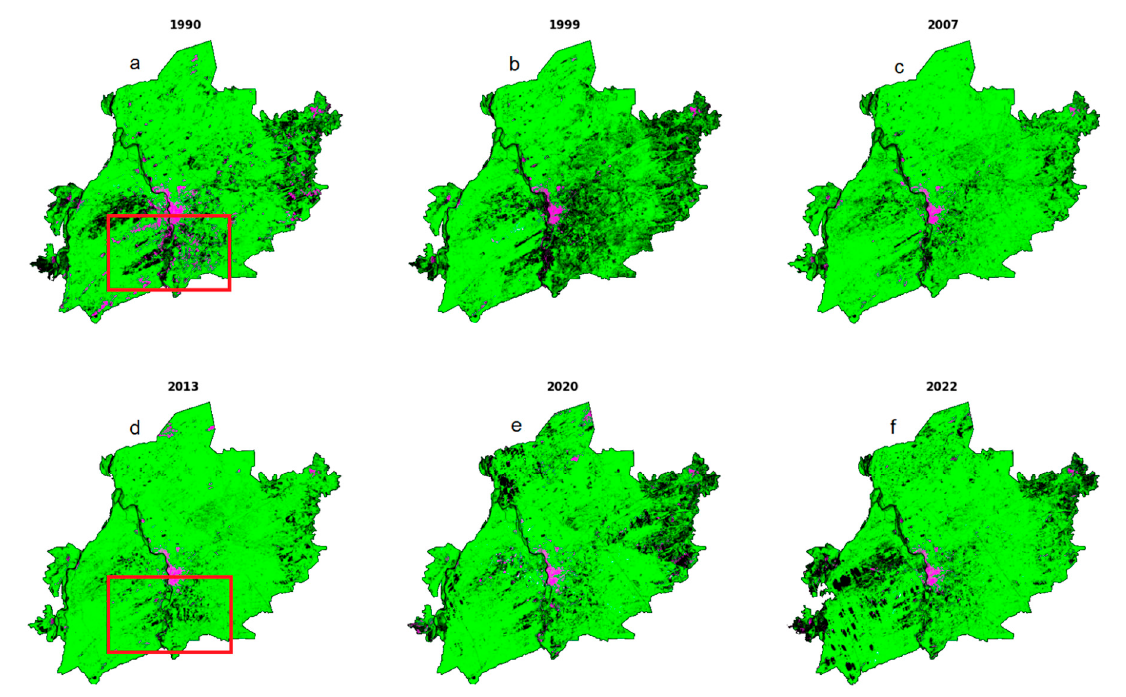
Figure 5. Mapping of forest vegetation in the Tomsk agglomeration. Legend: green for vegetation, purple for urban areas, black for other areas: ( a )—1990 year; ( b )—1999 year; ( c )—2007 year; ( d )—2013 year; ( e )—2020 year; ( f )—2022 year. Red box is maximum changes after initial state.